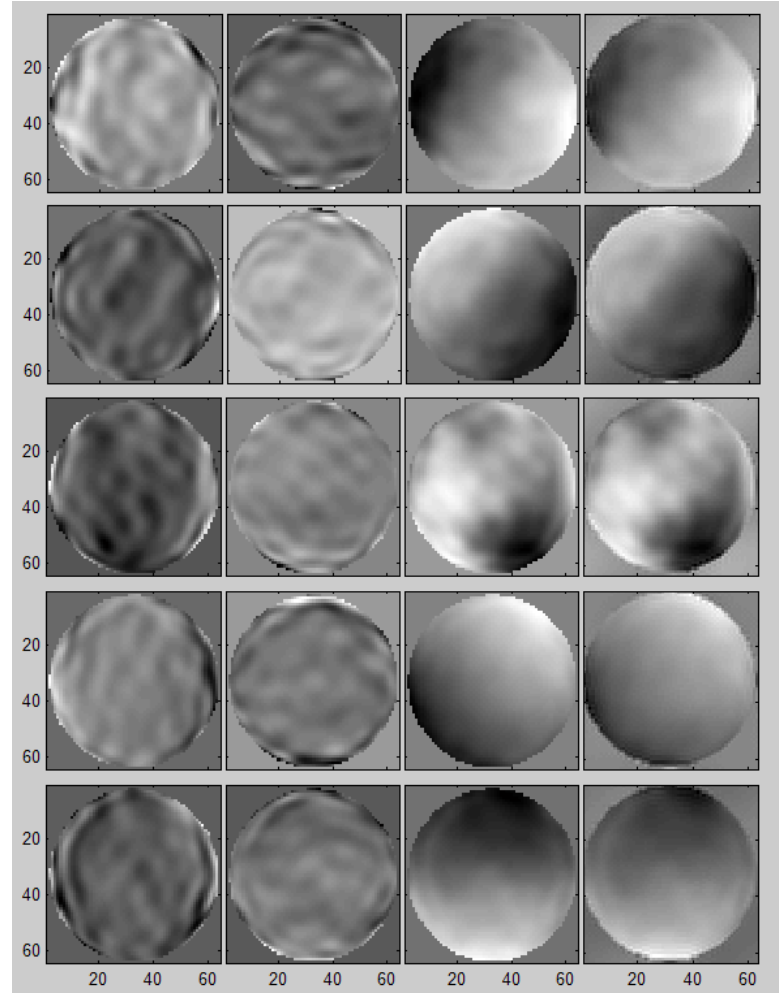
Figure 10. Phase gradients and original and recovered phase for a CAFADIS camera with 64 × 64